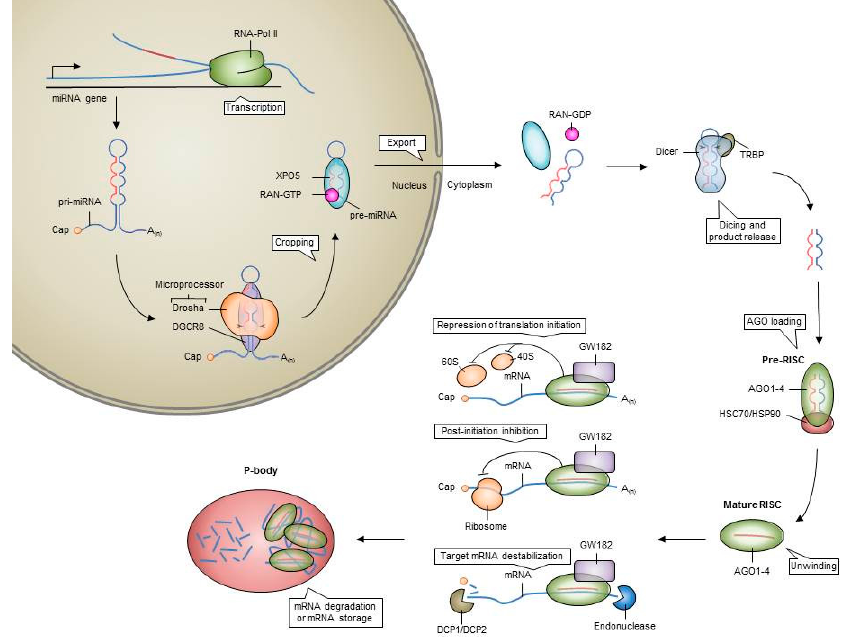
Figure 2. MicroRNA biogenesis and function. Primary miRNAs (pri-miRNA) are transcribed from miRNA genes by RNA polymerase II (RNA-Pol II). In the nucleus, the endonuclease Drosha together with a double-stranded RNA (dsRNA)-binding protein (DGCR8) cleave the stem–loop structure of the pri-miRNA. This results in a precursor miRNA (pre-miRNA) which is exported from the nucleus by exportin 5 (XPO5). In the cytoplasm, the pre-miRNA is then further cleaved by the endonuclease Dicer leading to a miRNA–miRNA* duplex. This duplex is loaded into an Argonaute (AGO) protein. The mature RNA-induced-silencing complex (RISC) is formed when miRNA*-strand is expelled from the AGO protein. The RISC complex can inhibit initiation of translation by affecting recruitment of 40S small ribosomal subunit and/or by inhibiting the 60S subunit. Alternatively, RISC may obstruct translation by inhibiting the elongation of ribosomes. RISC binding can also lead to recruitment of RNA decapping and/or deadenylating enzymes leading to mRNA destabilization. Some of the target mRNAs bound by the RISC are transported into cytoplasmic processing bodies (P-bodies) for degradation or